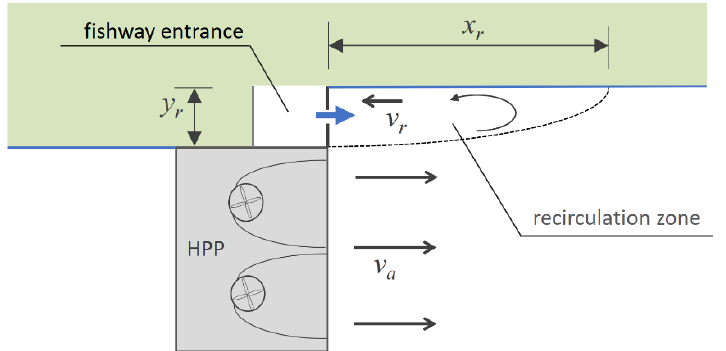
Figure 6. Schematic sketch to visualize the recirculation zone and reverse flow present in a fishway entrance bay; x r = length of recirculation zone; v r = reverse flow velocity; v a = mean ambient velocity; y r = lateral offset of fishway entrance